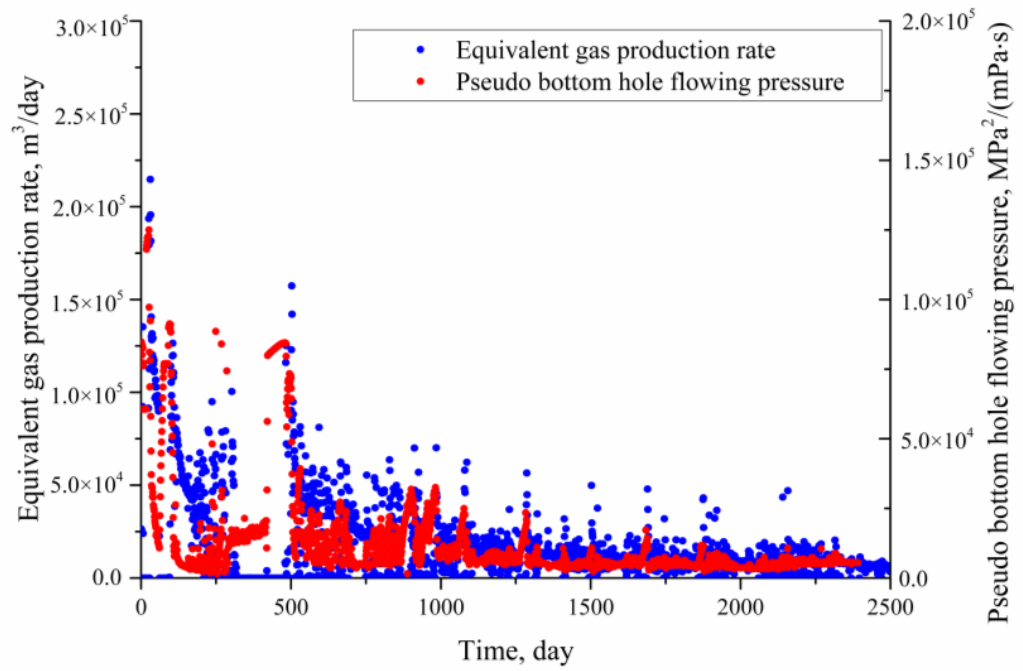
Figure 7. Equivalent gas production rate and pseudo bottom hole flowing pressure of the multi-stage fractured horizontal well.